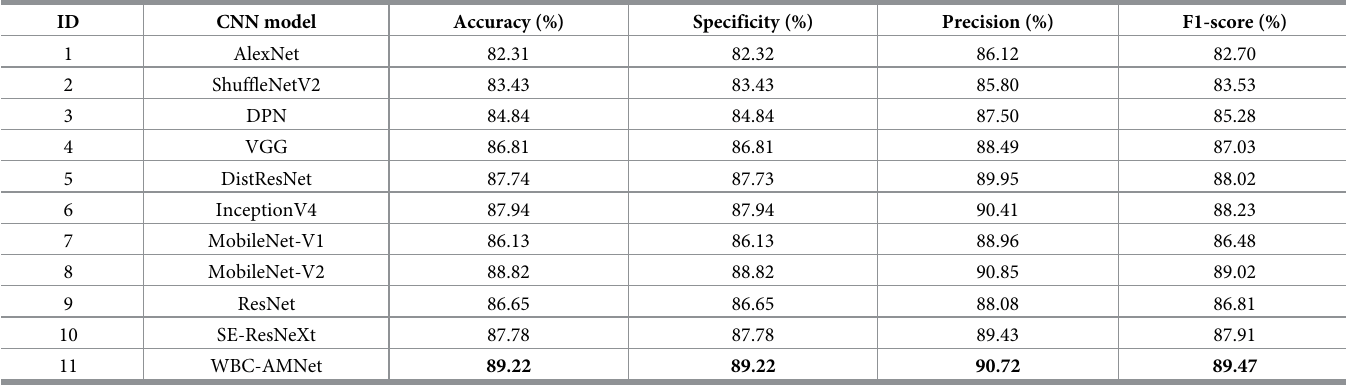
Table 7. Statistical results of nine classic CNN